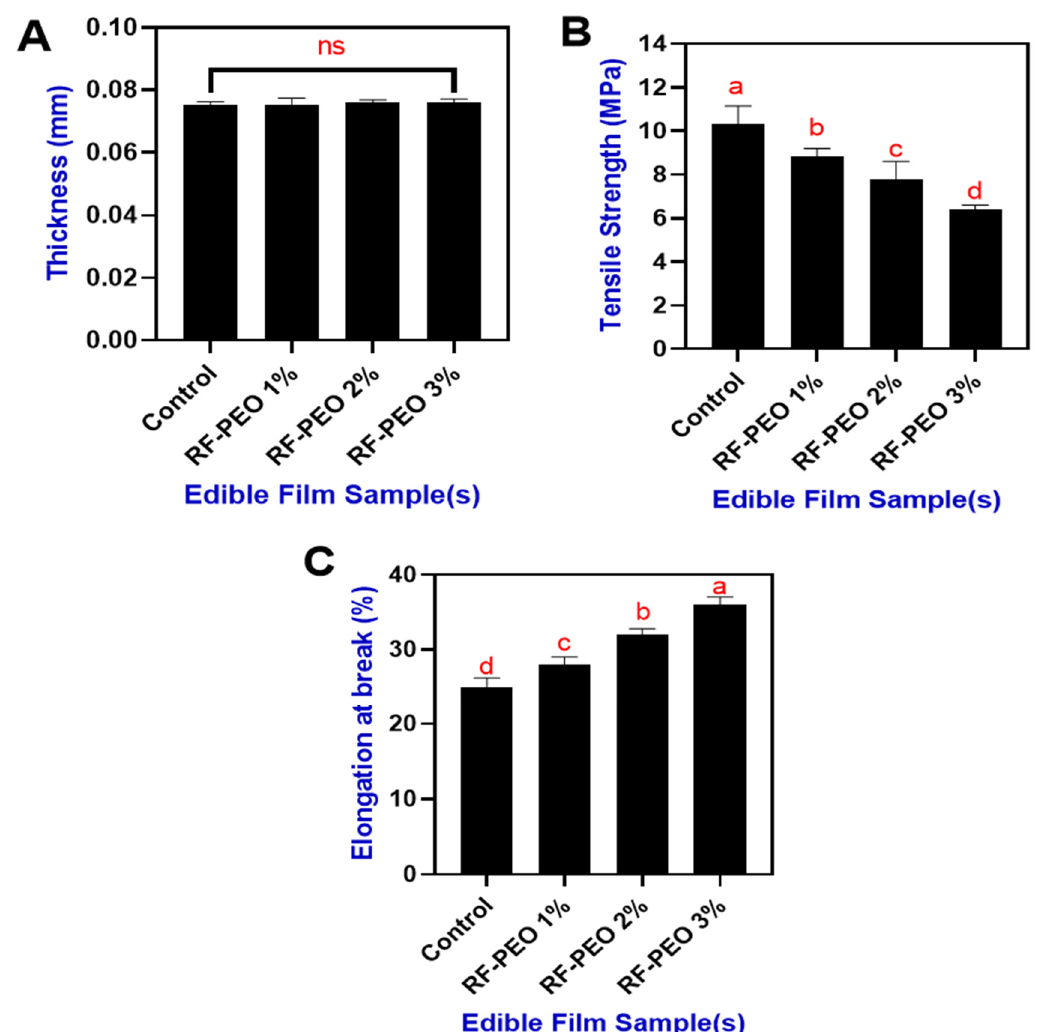
Figure 5. Thickness ( A ), tensile strength ( B ) and elongation at break ( C ) of edible films made of RF-PEO at varying concentrations. The different letters of the alphabet shown on the bar diagram indicate significant differences and ns indicates non-significant differences.